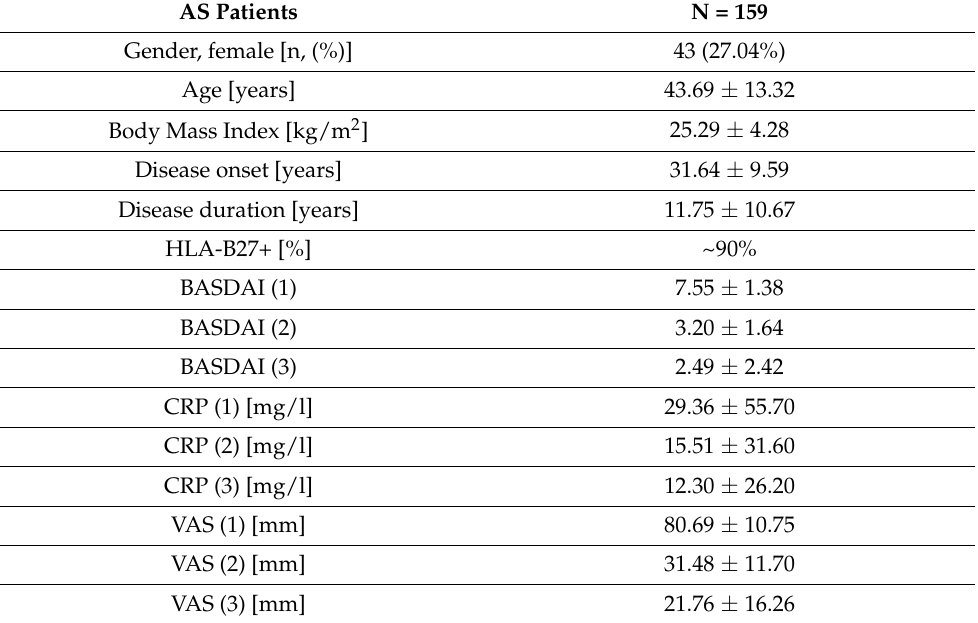
Table 2. Characteristic of patients with AS. AS